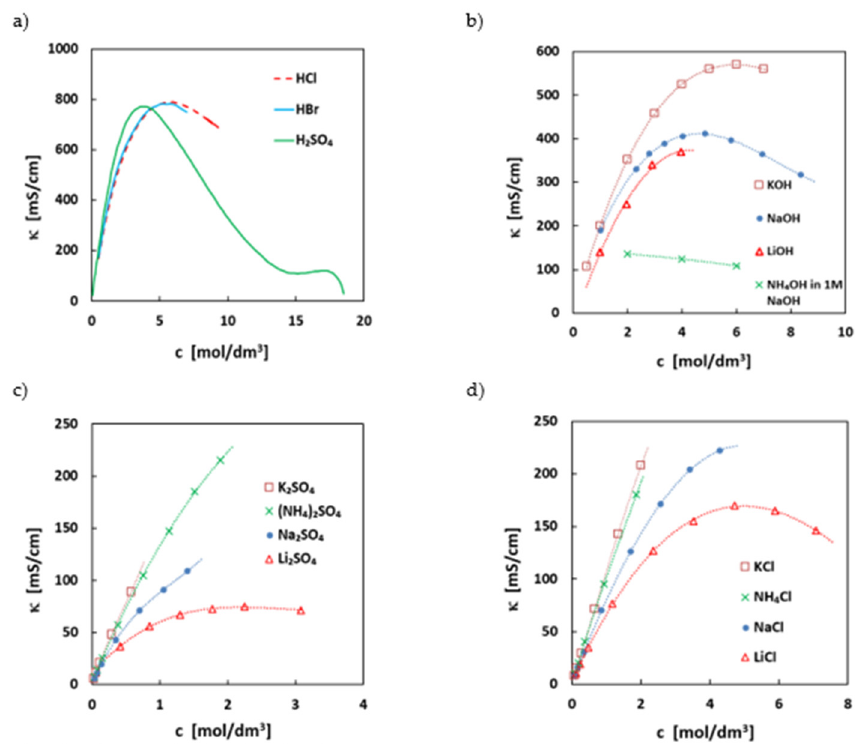
Figure 3. Variation of the specific conductance ( κ ) with the concentration (c) for some electrolyte solutions used in RFB at 293.15 or 298.15 K. ( a ) sulfuric acid [40], hydrochloric acid [41], and hydrobromic acid [41]; ( b ) sodium hydroxide ( • ) [42], potassium hydroxide ( (cid:3) ) [43]; lithium hydroxide ( ∆ ) [44], and ammonium hydroxide in 1 mol/L aqueous NaOH (x) [45]; ( c ) sodium sulfate ( • ) [46], potassium sulfate ( (cid:3) ) [46], lithium sulfate ( ∆ ) [47], and ammonium sulfate (x) [46]; ( d ) sodium chloride ( • ) [46], potassium chloride ( (cid:3) ) [46], lithium chloride ( ∆ ) [46], and ammonium chloride (x)